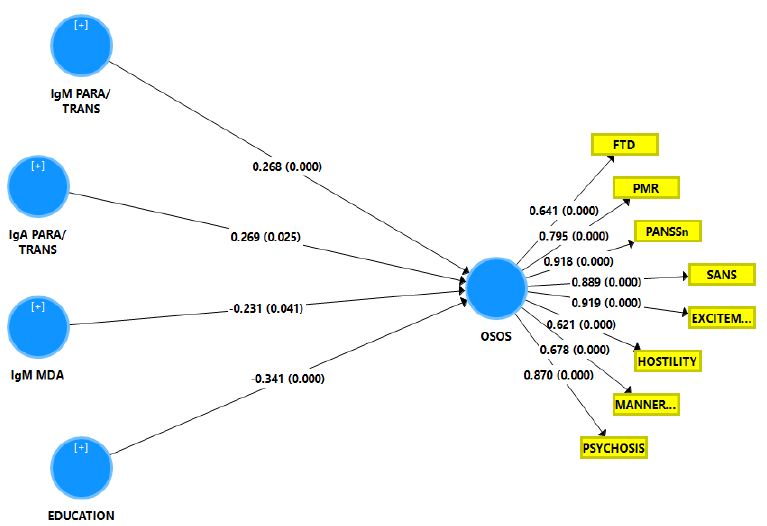
Figure 4 . Results of Partial Least Squares (PLS) analysis. This analysis is performed in the schizophrenia study group with a latent vector extracted from the eight symptom domains as an output variable (named: overall severity of schizophrenia or OSOS) and the biomarkers, and education as input variables. SANS: Scale for the Assessment of Negative Symptoms; PANSS: the Positive and Negative Syndrome Scale; FTD: formal thought disorders; PMR: psychomotor retardation (see table 1 for computation). IgA/IgM PARA/TRANS: IgA/IgM directed to paracellular / transcellular proteins; IgM MDA: IgM values directed to malondialdehyde. Shown are the path coefficients for the inner model and factor loadings for the outer model obtained by 5000 bootstrap